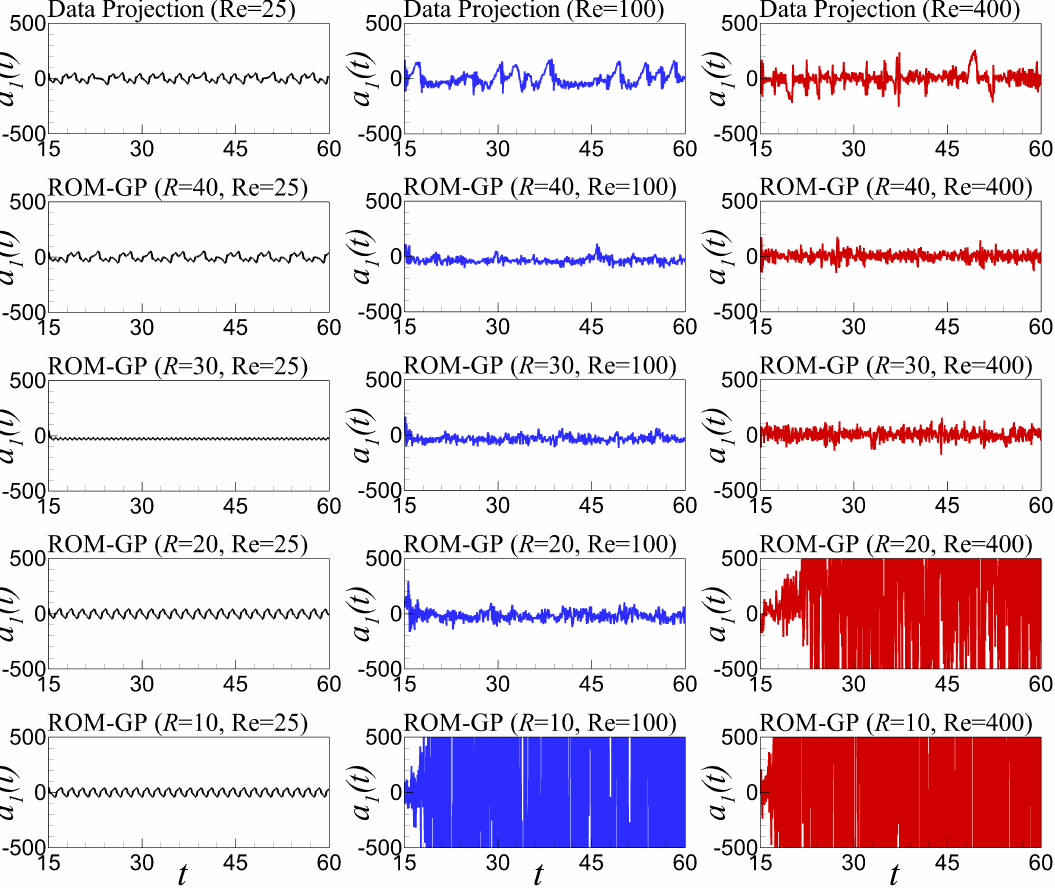
Figure 8. Time series evolution of the first modal coefficient, a 1 ( t ) between t = 15 and t = 60 for FOM projection and standard ROM-GP with varying Re (Re = 25,100,400) and POD modes ( R = 10,20,30,40). R = 20 modes for Re = 100, and R = 30 modes for Re =